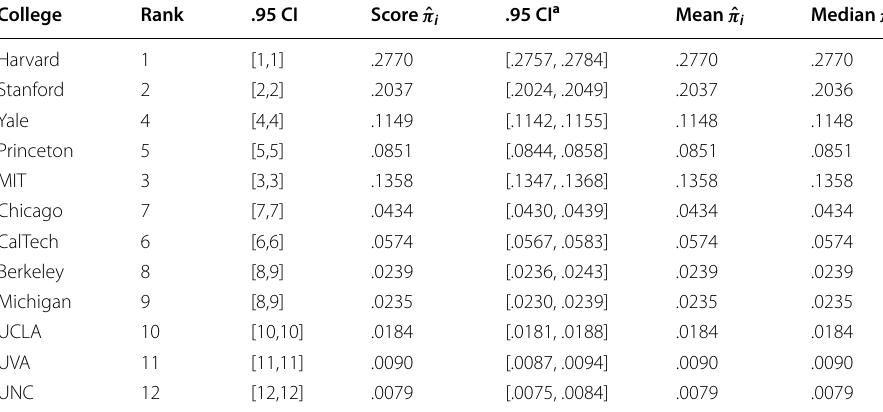
Table 4 A mini sample college